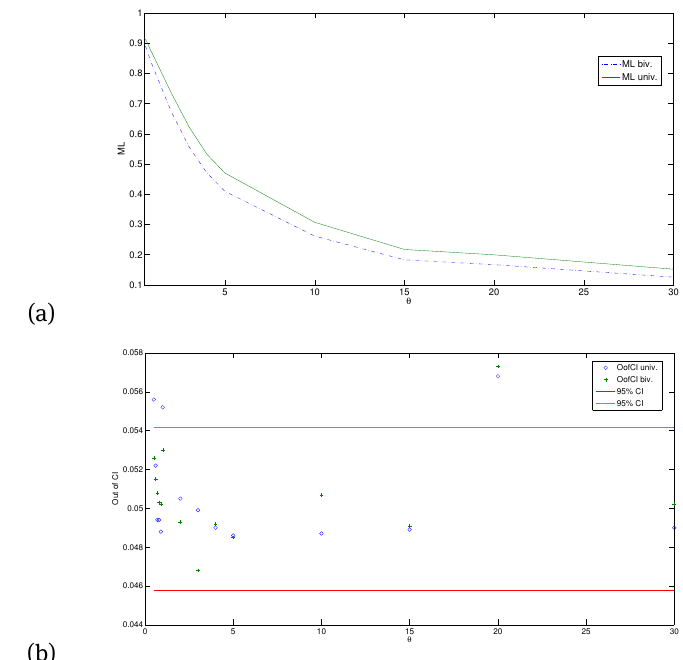
Figure 4: Impact of the parameter θ in the Clayton copula. In panel (a), the plain line represents the value of ML α N and the α dashed gives the value of (cid:99) ML N . Panel (b) gives the proportion of observed values outside of prediction intervals. The circles give the results for prediction intervals based on univariate series while plus signs are for prediction intervals based on bivari- ate series, and the horizontal lines give the 95% confidence interval. The x-axis gives the values of θ .